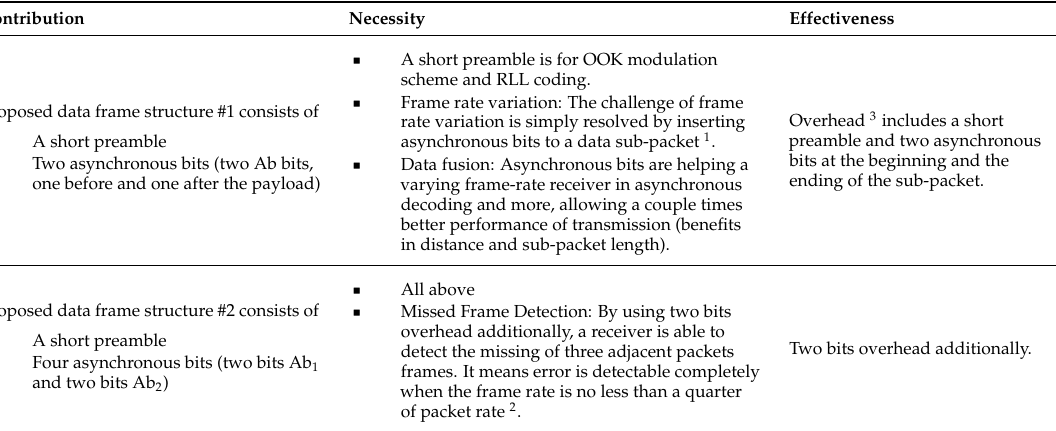
Table 2. Highlights of our